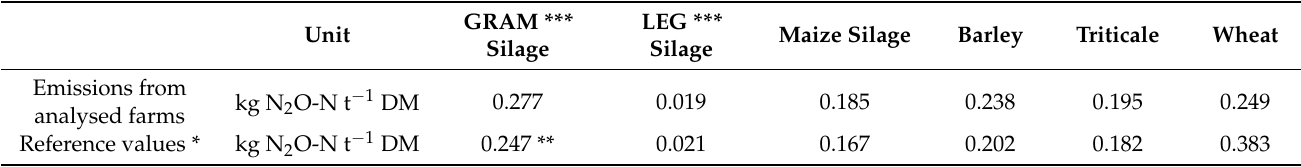
Table 8. Comparison of N 2 O emissions from analysed farm fertilisation and from standard fertilisation according to the KTBL